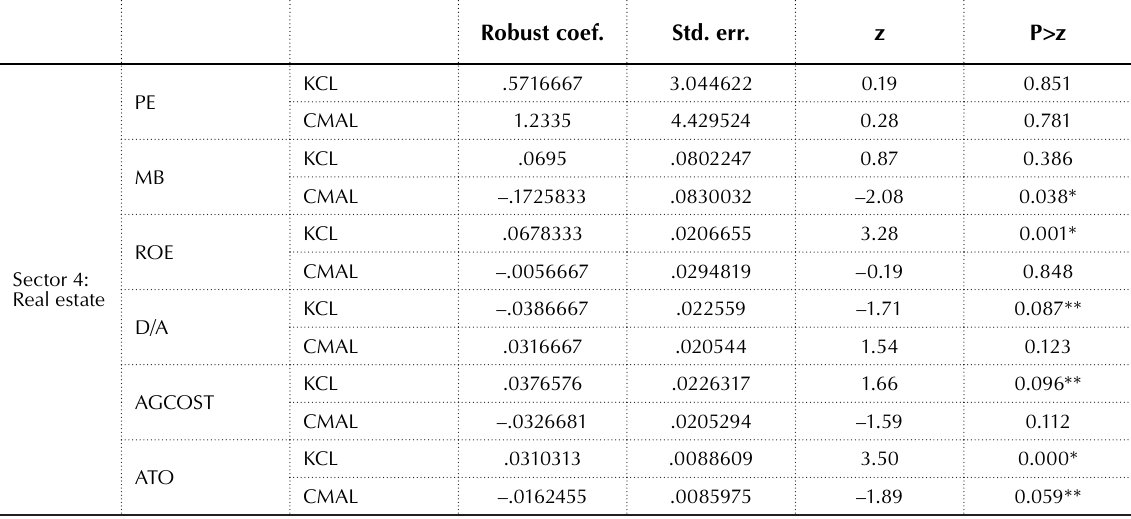
Table 10. GLS panel data regression for the real estate sector Robust coef. Std. err.